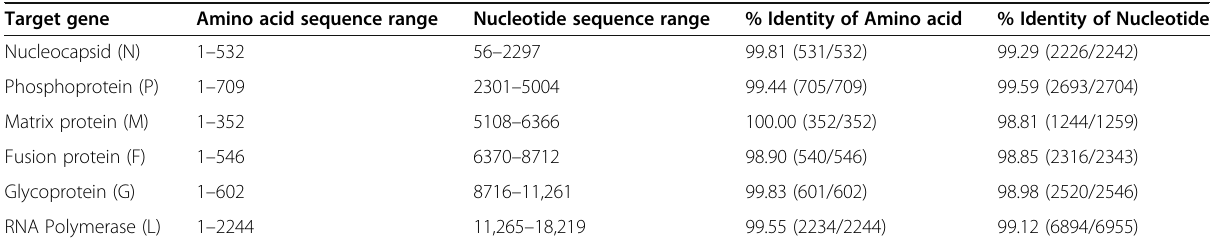
Table 3 Identity shared between THAB17640.GUL with NiV from Bangladesh patient in 2004 (GenBank Accession No. AY988601.1) Target